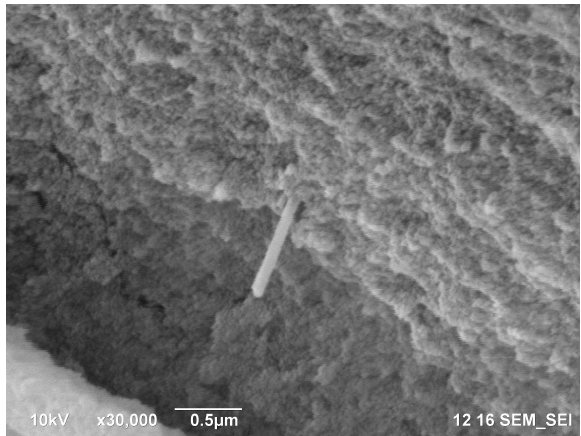
Figure7. SEMmicrographofthesilicagelwith0.05%halloysitecleavedinliquidnitrogen. Thehalloysite Figure 7. SEM micrograph of the silica gel with 0.05% halloysite cleaved in liquid nitrogen. The nanotube is visible in the center of the image. Scale bar, 500 halloysite nanotube is visible in the center of the image. Scale bar, 500 nm.